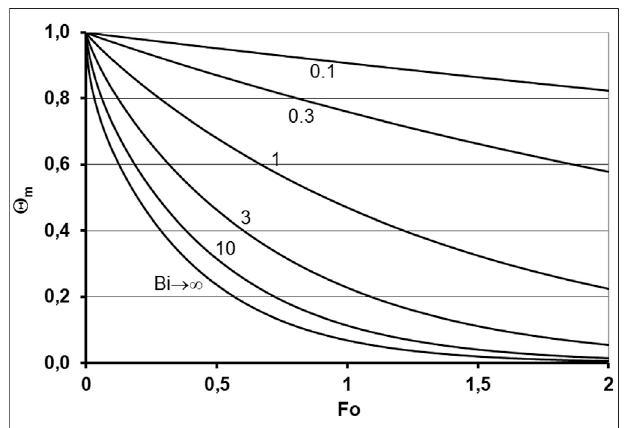
FIGURE 3 | Mean dimensionless temperature for one-dimensional heat fl ow and one adiabatic surface in relation to Biot and Fourier